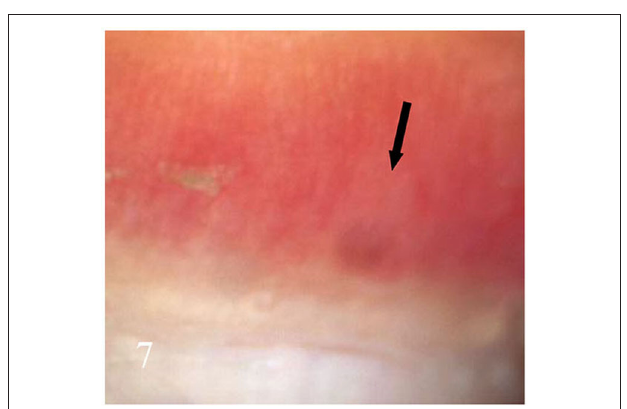
FIGURE 3 | White flocculent nail plate changes.